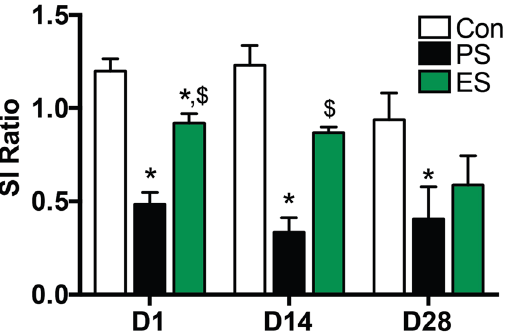
Figure 1. Establishment of chronic social defeat stress (CSDS). Social interaction (SI) was assessed at three time points (Day (D) 1, D14, D28) in separate cohorts following physical (PS) and emotional (ES) stress. D1: control n = 20, PS n = 27, ES n = 24; D14 and 28: control, PS, and ES n = 5 mice/group; * p < 0.05 compared to control, $ p < 0.05 compared to PS, Tukey’s post-hoc